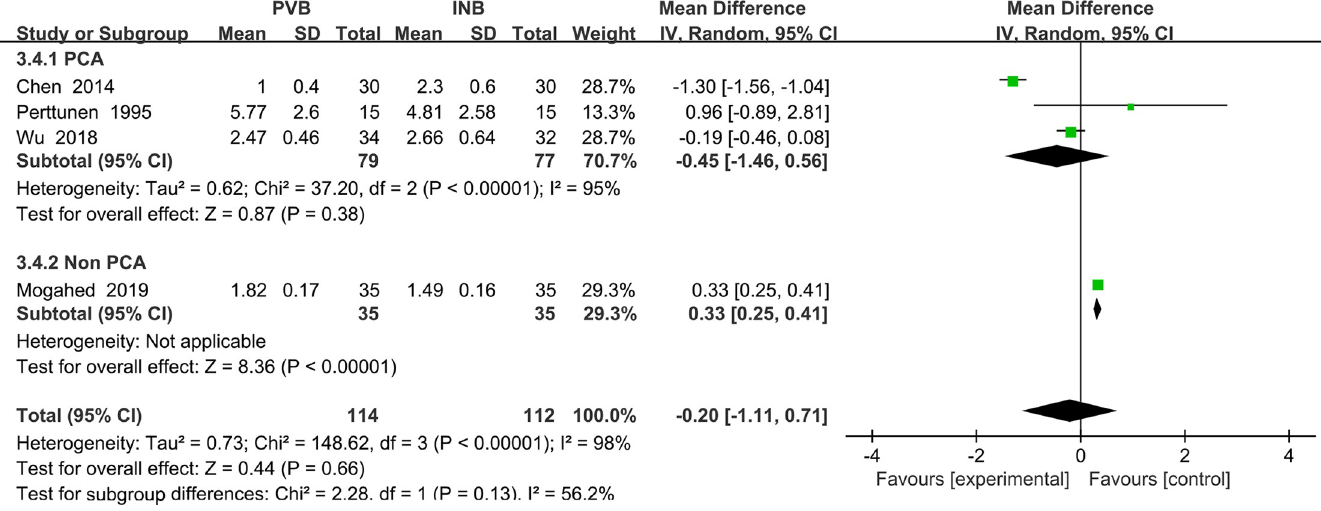
PLOS ONE | https://doi.org/10.1371/journal.pone.0237363 October 5,